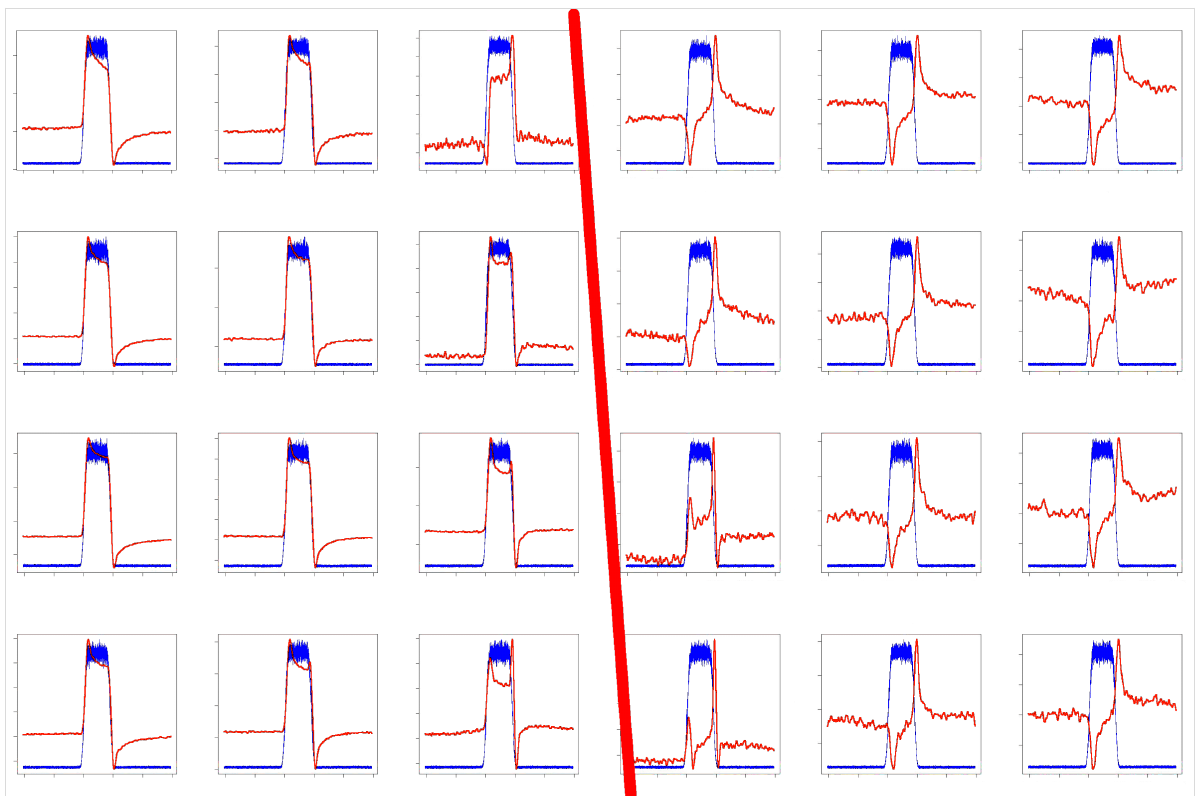
Figure 3: Spatial dependence of the light-induced signal (see Figure 2a) for the two working electrodes. The probed area (90 × 60 µm 2 ) is split by the gap between the electrodes as the red line indicates.